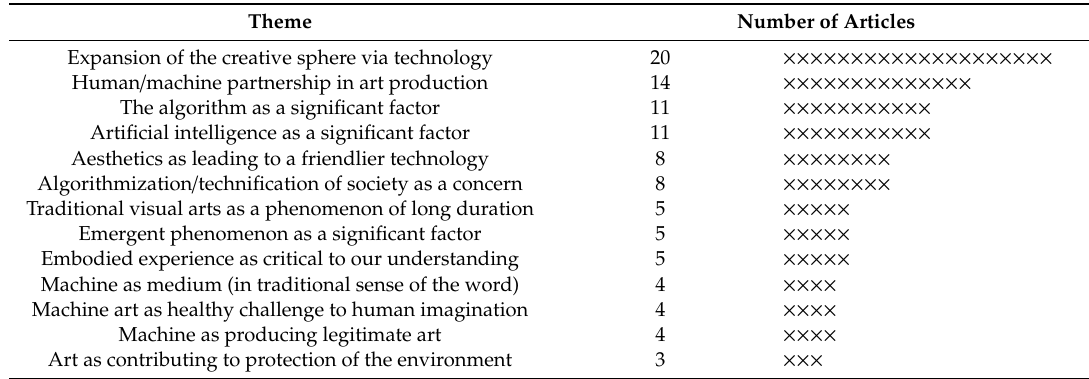
Table 1. Major themes of the two Arts Special Issues “The Machine as Art (in the 20th Century)” and “The Machine as Artist (for the 21st